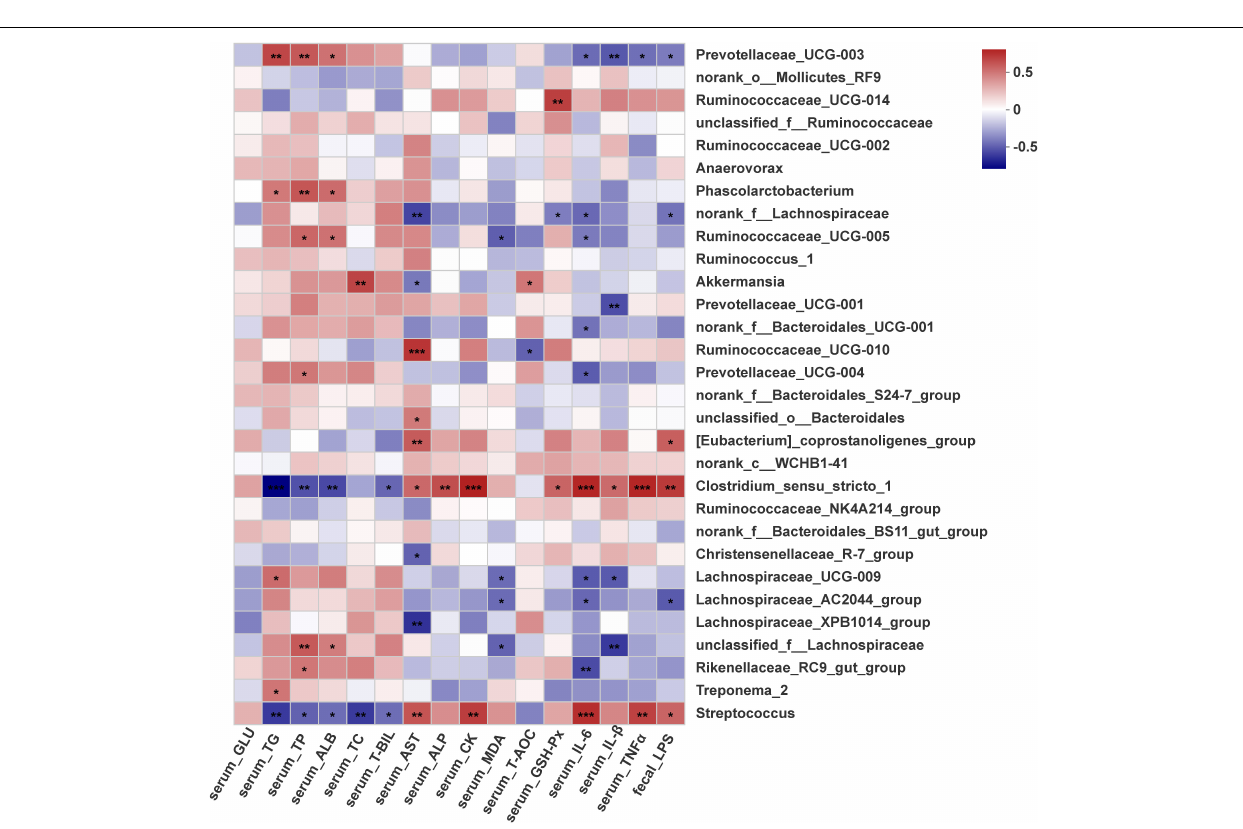
FIGURE 5 | Important bacterial functions identified using random forest analysis. (A) The top 25 important bacterial functions according to random forest analysis. (B) The distribution of the important bacterial functions in different groups. C, non-pregnancy as a control; EP, early-stage pregnancy; MP, middle-stage pregnancy; LP, late-stage pregnancy.